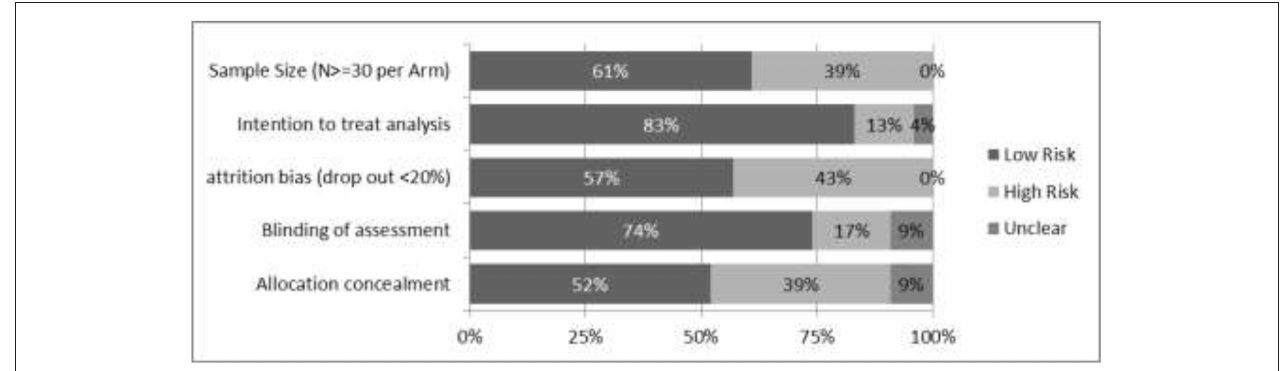
FIGURE 3 | Ratings of items related to risk of bias. Risk of bias across all studies included in the network meta-analysis (coders assessment), presented as percentages of ratings (low risk: rated “yes;” high risk: rated “no”). Further possible risks of bias: Selective outcome reporting: Registration in a trial register or published study protocols were available for more recent studies only. Therefore, selective outcome reporting could not be assessed. Researcher allegiance (RA): It was taken care of that coders were independent and not involved in the studies they had to rate. The study group consisted of experts representing a broad range of therapeutic orientations (CBT, psychodynamic, family) and backgrounds (psychology, psychosomatic medicine, child, and adolescent